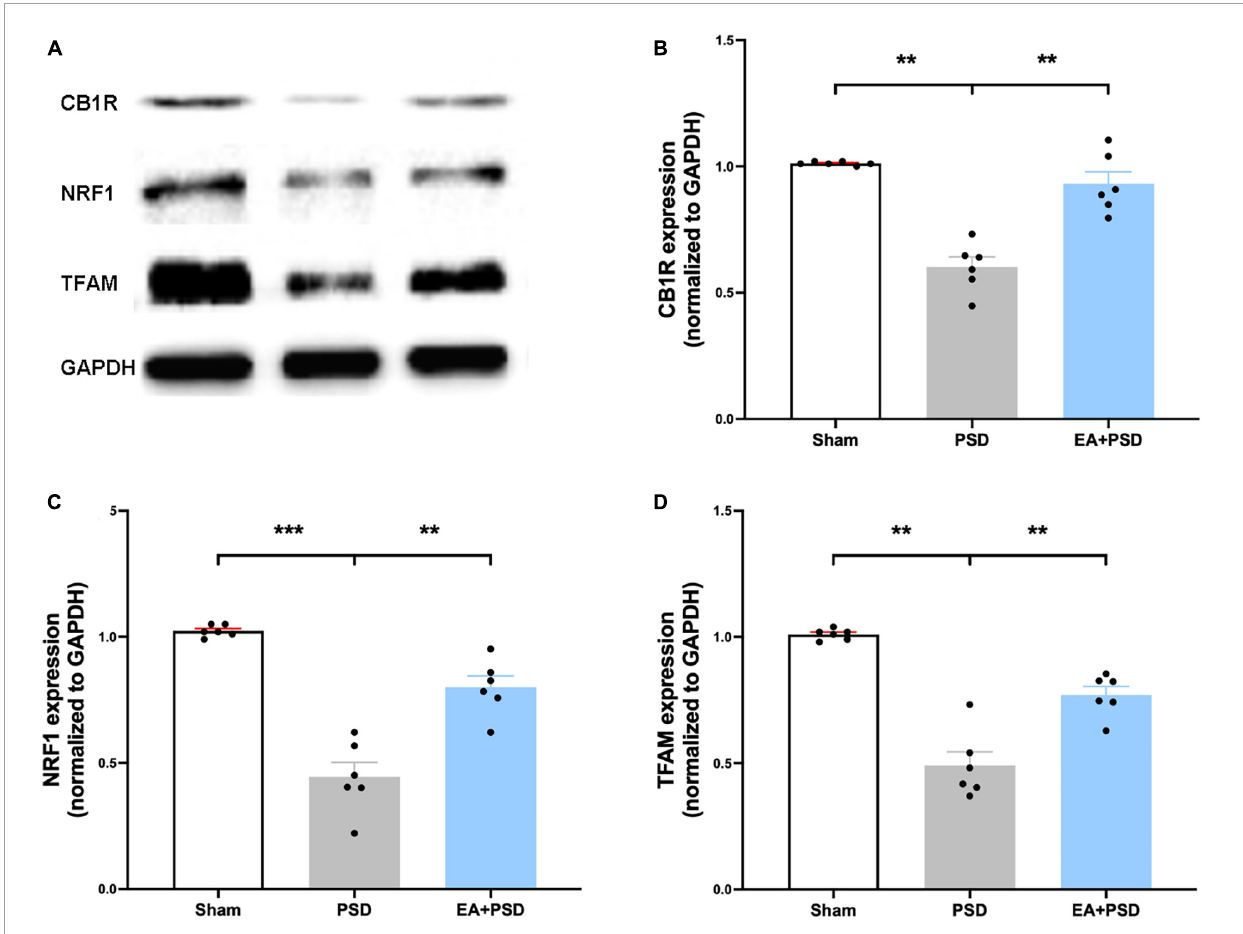
FIGURE3 EA treatment improved the CB1R expression and mitochondrial biogenesis. (A) Photographs of reprehensive bands of CB1R, NRF1 and TFAM. (B) The exposure of PSD inhibited CB1R expression in hippocampus, which was reversed by EA treatment ( n = 6, ** P < 0.01). (C) Quantitative changes in NRF1 in the hippocamps after PSD or EA procedure. PSD attenuated the protein expression of NRF1, whereas EA treatment reversed this reduction ( n = 6, ** P < 0.01). (D) PSD operation reduced the abundance of TFAM, EA treatment reversed this decrease ( n = 6, ** P <